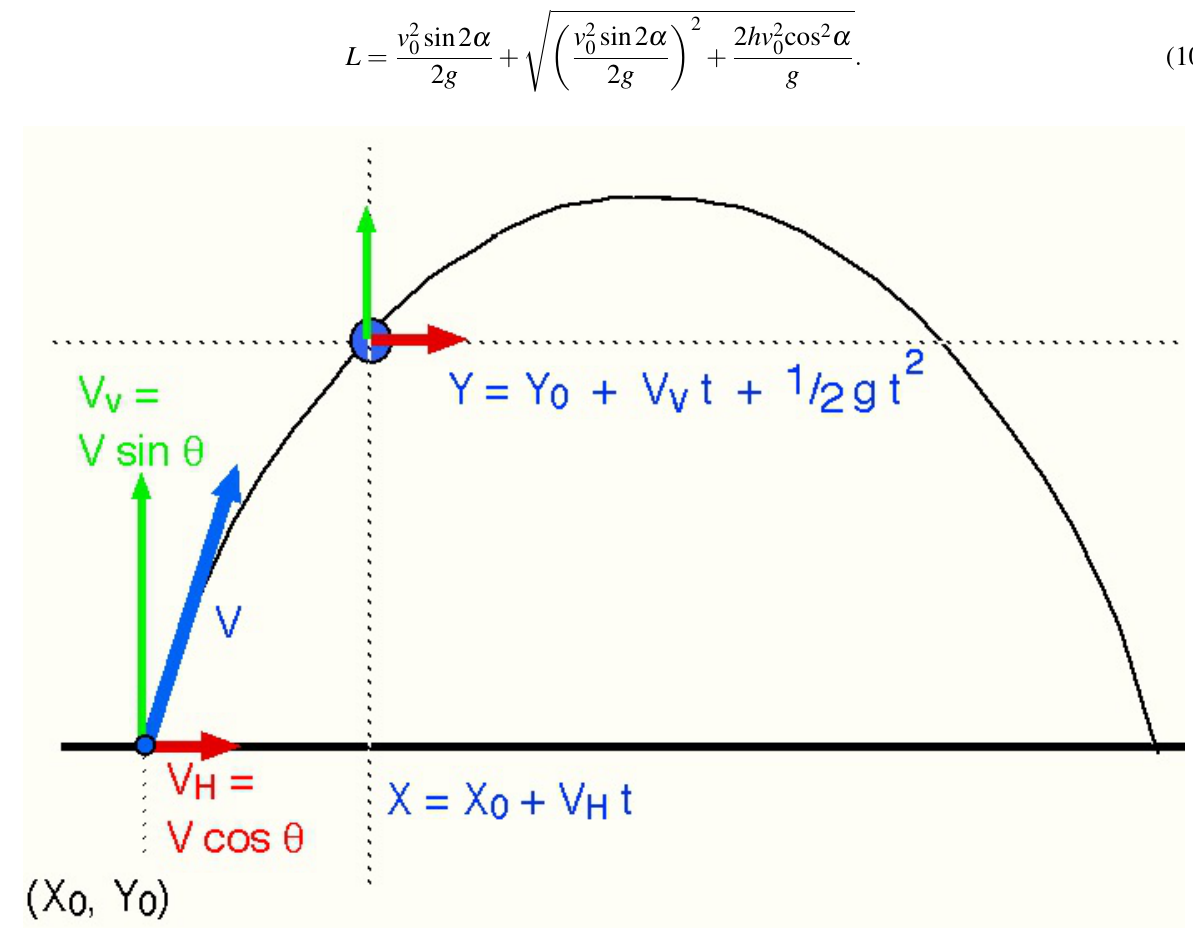
Fig. 2 The coordinates of the shot